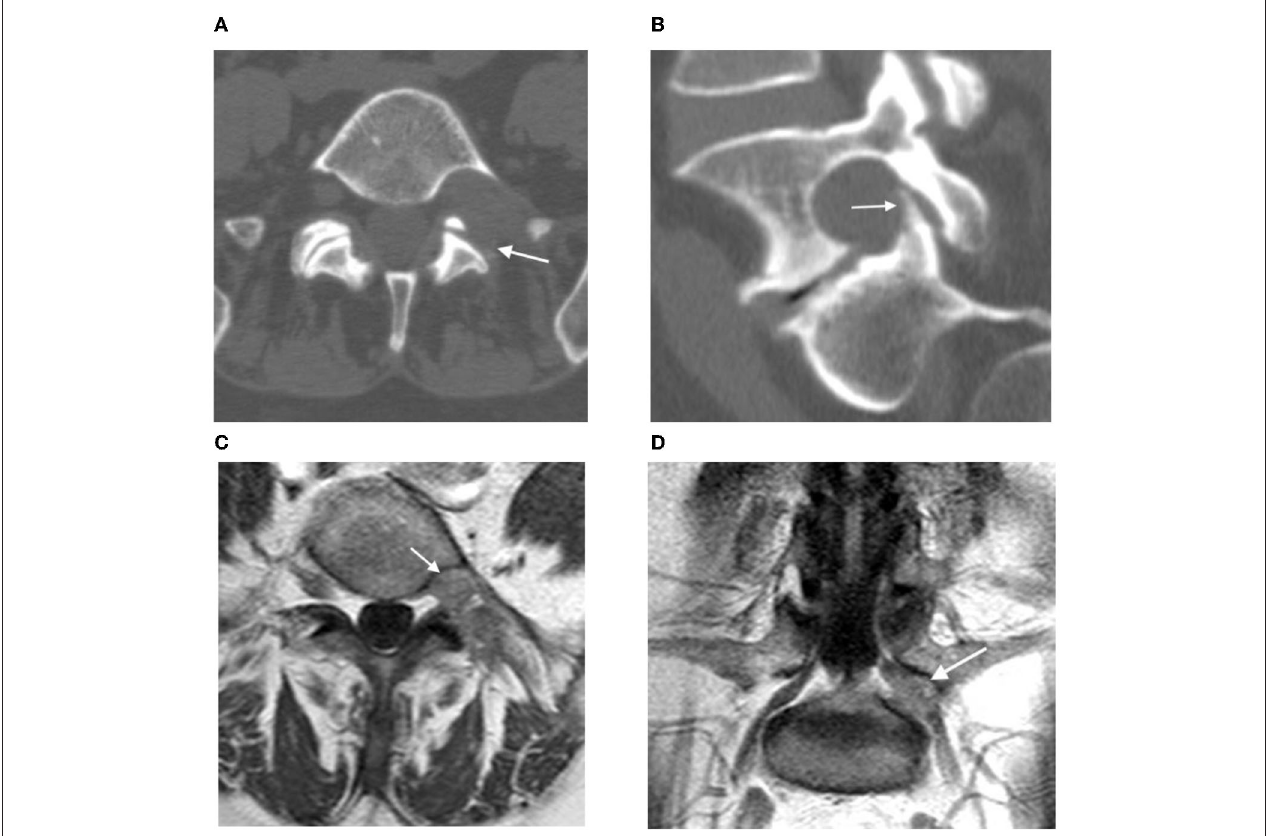
FIGURE 4 | (A,B) Postoperative CT: the arrow shows the resection area of the left intervertebral joint L5-S1; (C,D) contrast-enhanced MRI 3 months after surgery: postoperative changes in the left L5 root (see arrow), no signs of contrast accumulation.